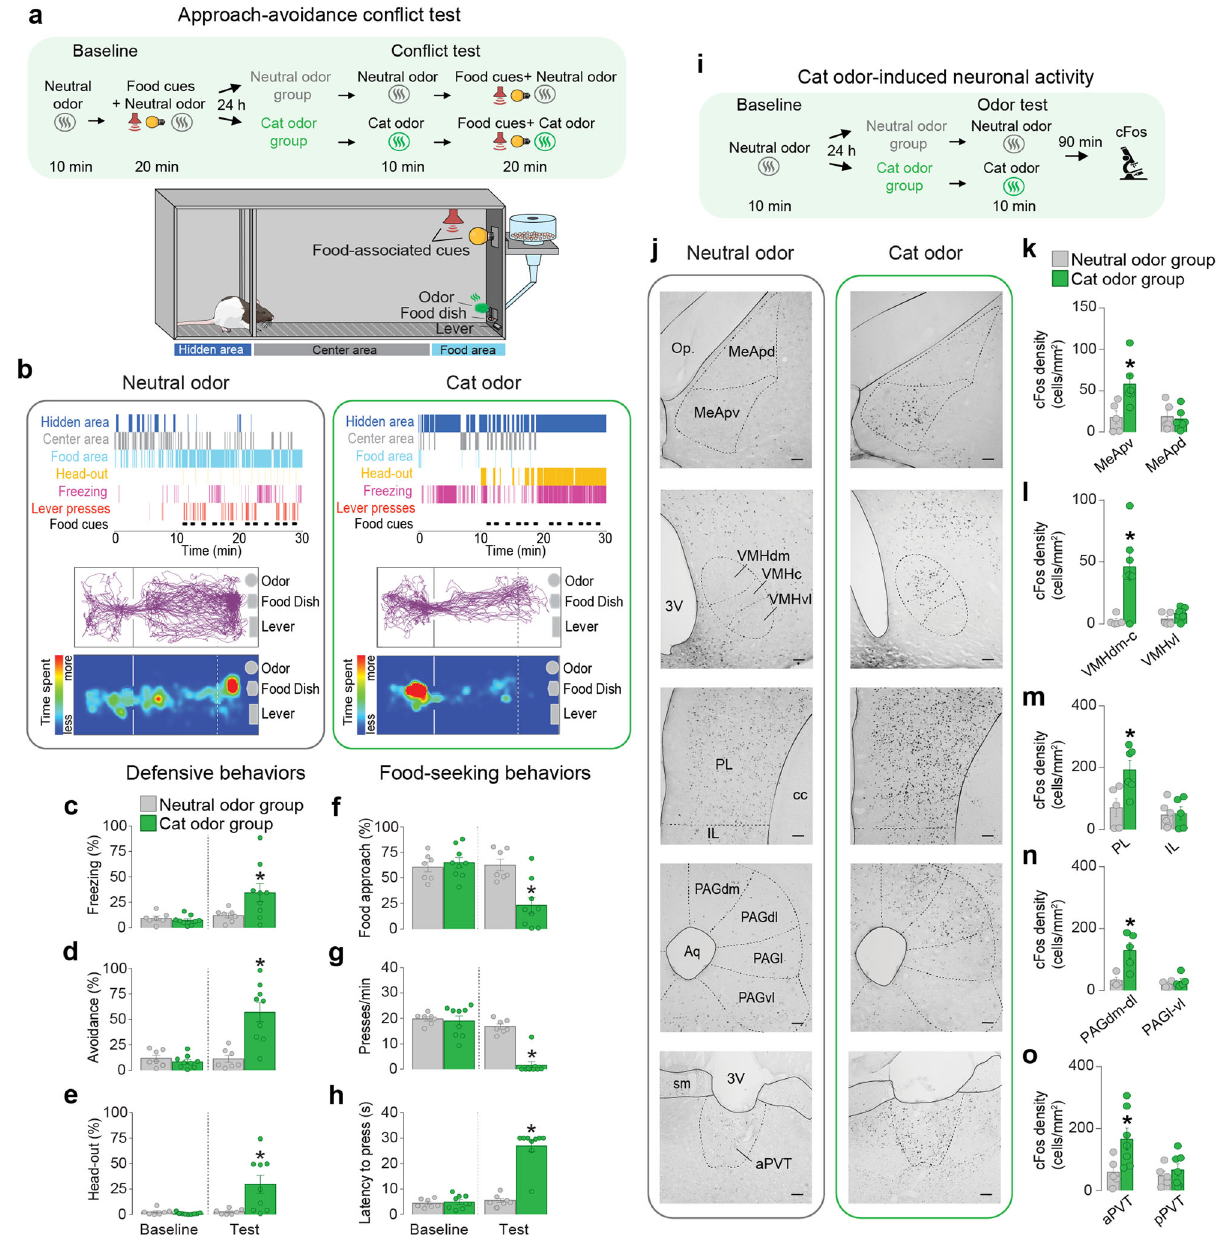
Fig. 1 Cat odor exposure induces defensive behaviors, suppresses food seeking, and increases cFos expression in the aPVT. a Timeline and schematic of the approach-avoidance con fl ict test. b Representative ethogram (top), tracks (center), and heatmaps (bottom) of rats exposed to neural odor (left) or cat odor (right). c – h During the con fl ict test, rats exposed to cat odor (green bars, n = 9) showed an increase in the percentage of time exhibiting freezing ( F (1, 14) = 5.39, P = 0.035), d avoidance ( F (1, 14) = 21.85, P < 0.001), and e head-out responses ( F (1, 14) = 7.01, P = 0.019); and a decrease in the percentage of time f approaching the food area ( F (1, 14) = 28.31, P < 0.001), a suppression in the number of g lever presses ( F (1, 14) = 29.93, P < 0.001), and a prolonged h latency to press the lever ( F (1, 14) = 67.27, P < 0.001), when compared to neutral odor controls (gray bars, n = 7; two-way repeated-measures ANOVA followed by Bonferroni post hoc test). i Timeline of the cat odor-induced neuronal activity test. j Representative micrographs of cFos immunoreactivity (dark dots) in neutral odor (left) and cat odor (right) groups. k – o Cat odor exposure (green bars, n = 7) increased the number of cFos-positive neurons in k the posteroventral subregion of the medial amygdala (MeApv, P = 0.019, t = 2.834), l the dorsomedial-central subregion of the ventromedial hypothalamus (VMHdm-c, P = 0.0075, t = 3.34), m the prelimbic cortex (PL, P = 0.034, t = 2.44), n the dorsomedial and dorsolateral subregions of the periaqueductal gray matter (PAGdm-dl, P = 0.015, t = 3.195), as well as in the o anterior subregion of the paraventricular nucleus of the thalamus (aPVT, P = 0.039, t = 2.372), when compared to neutral odor con t rols (gray bars, n = 5, unpaired Student ’ s t test). pPVT posterior subregion of the paraventricular nucleus of the thalamus, MeApd posterodorsal subregion of the medial amygdala, VMHvl ventrolateral subregion of the ventromedial hypothalamus, IL infralimbic cortex, PAGl lateral subregion of the periaqueductal gray matter, PAGvl ventrolateral subregion of the periaqueductal gray matter. Scale bars: 100 µ m. Data are shown as mean ± SEM, * P < 0.05. See also Supplementary Figs. 1, 2, and 3 and Supplementary Movies 1 and 2.